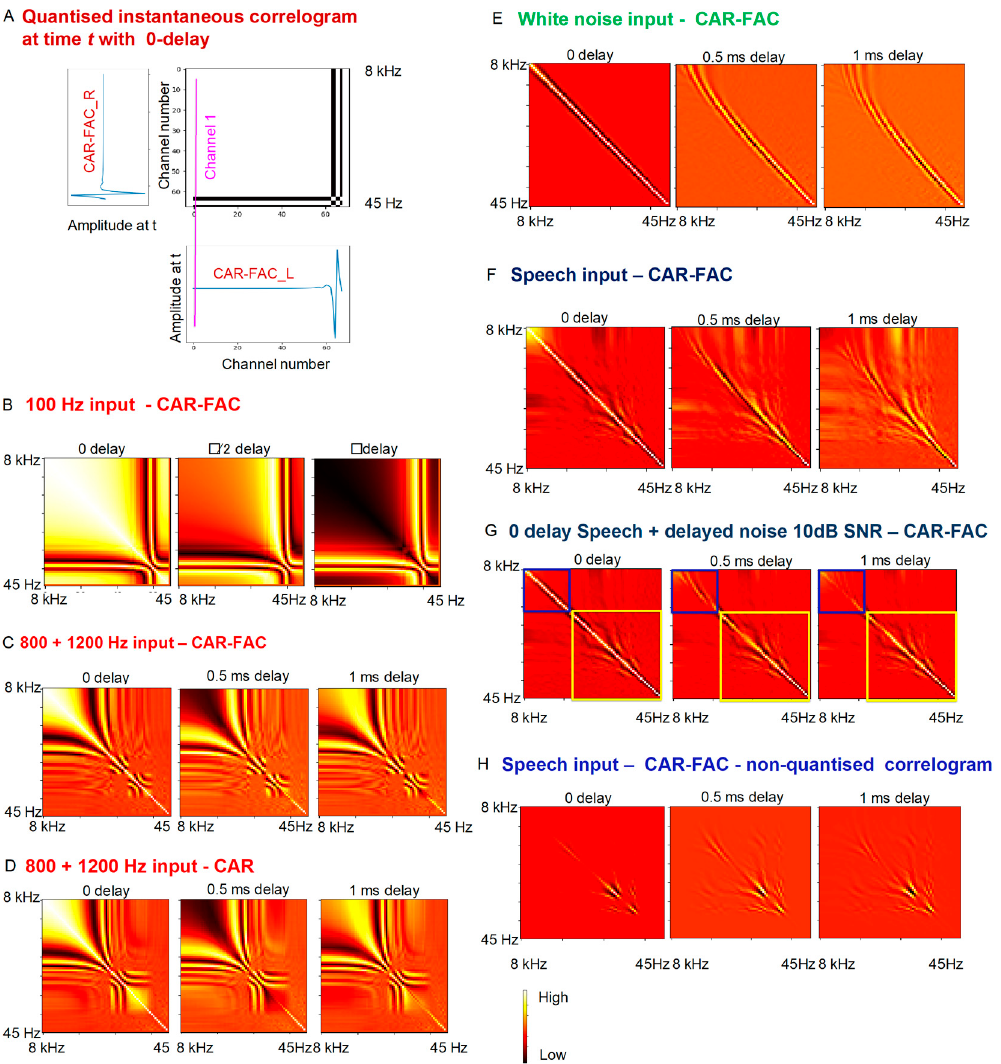
Figure 6. CAR-FAC quantised instantaneous correlogram (3) generated in response to ( A ) two 200 Hz sine tone at time t at zero delay; and averaged correlogram generated over the input duration in response to ( B ) two 200 Hz sine tone at zero, π /2, and π radians delay; ( C ) 800 Hz and 1200 Hz sine tones at 0, 0.5 ms, and 1 ms delays; ( D ) 800 Hz and 1200 Hz sine tones at 0, 0.5 ms, and 1 ms delays generated using the CAR only; ( E ) two white noise signals at 0, 0.5 ms, and 1 ms delays; ( F ) two speech signals, spoken digit “eight”, at 0, 0.5 ms, and 1 ms delays; and ( G ) two noisy speech signals at 0, 0.5 ms, and 1 ms noise delays. Note the speech is zero-delay in this example; ( H ) CAR-FAC non-quantised correlogram (2) generated in response to the same speech as in ( F